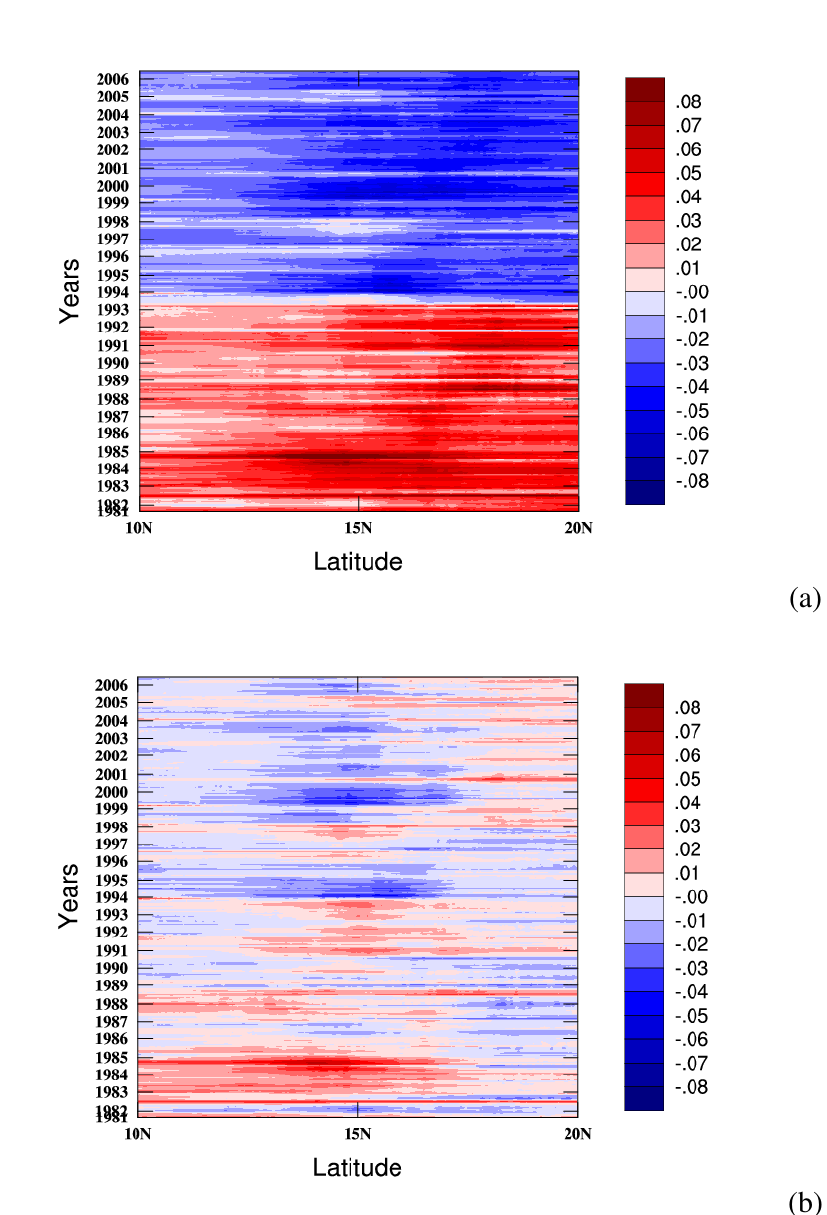
Figure 3. Time-latitude (Hovmoeller) diagrams of monthly Meteosat surface albedo anomalies based on different spectral conversion approaches: (a) broadband visible, based on original spectral conversion coefficients [18], (b) broadband visible based on new coefficients. Reference period for anomaly calculation: